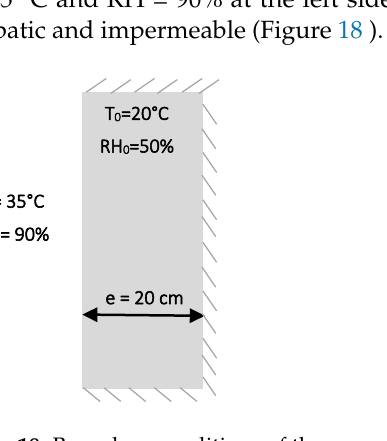
Figure 18. Boundary conditions of the comparison case study.